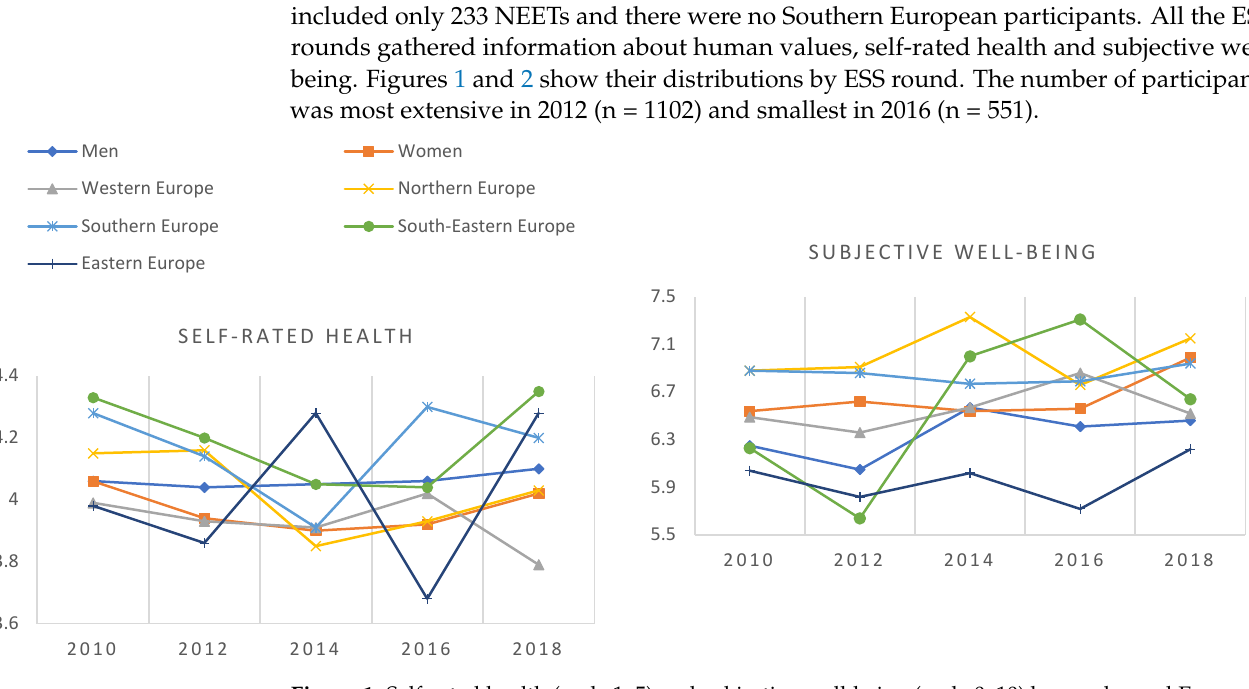
Figure 1. Self-rated health (scale 1–5) and subjective well-being (scale 0–10) by gender and European region among NEETs from 2010 to 2018 (ESS rounds 5–9).